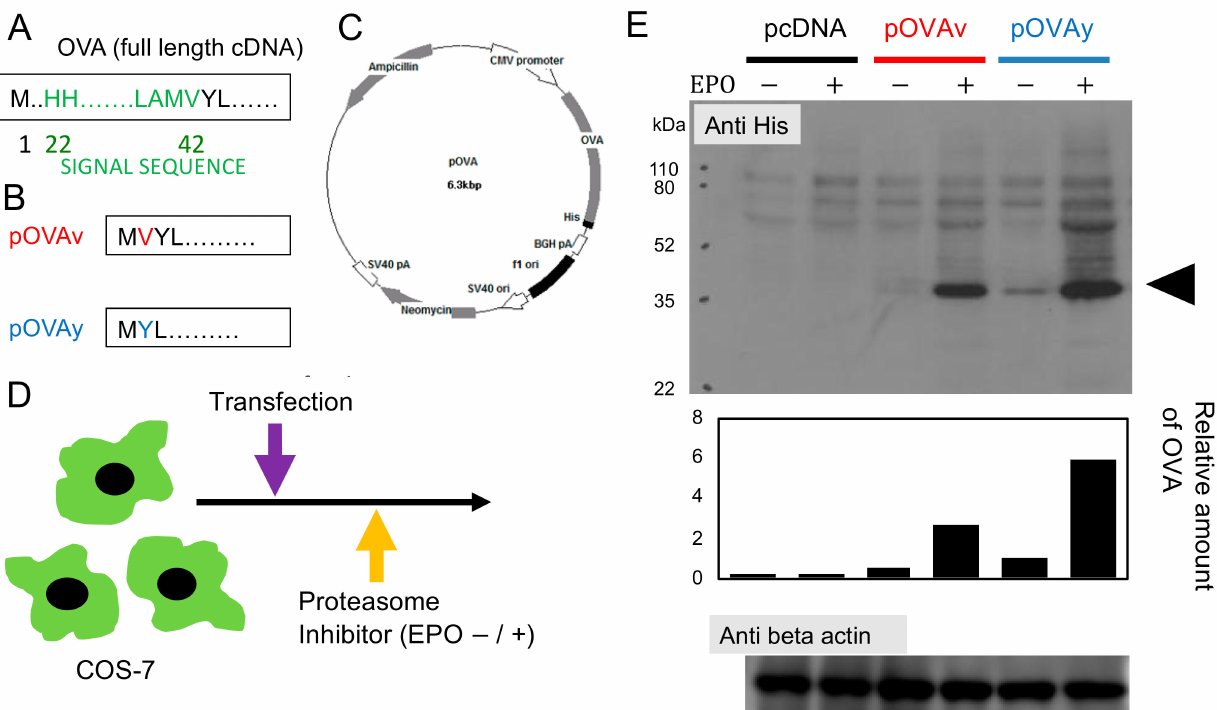
Figure 1. Plasmid construction and protein expression. ( A ) Ovalbumin (OVA) consists of 386 AA and has a signal sequence spanning from H22–V42. ( B ) The two plasmids used in this study start from the MV (pOVAv; 346AA) and MY (pOVAy; 345AA) of OVA without the signal sequence for the cytosolic form. ( C ) Plasmid map of pOVA (6.3 Kbp). Promoter: Cytomegalovirus (CMV), 6 × His tag at the C-terminus for Western blotting. ( D ) COS-7 cells were transfected with plasmid pcDNA, pOVAv, or pOVAy and incubated with or without the proteasome inhibitor epoxomicin (EPO). ( E ) Western blotting for His tag of target proteins. β -actin was used as the internal loading control. The arrowhead indicates the expected cytosolic OVA size. The detected band of OVA was analyzed by ImageJ. A representative image from two independent experiments is